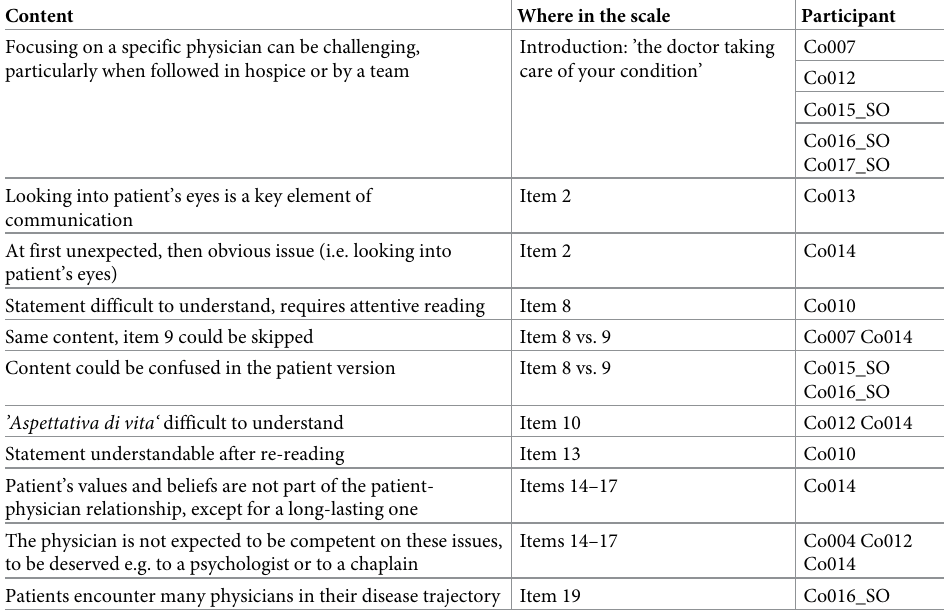
Table 4. Main findings of the cognitive debriefing of the Quality of Communication scale. SO, significant